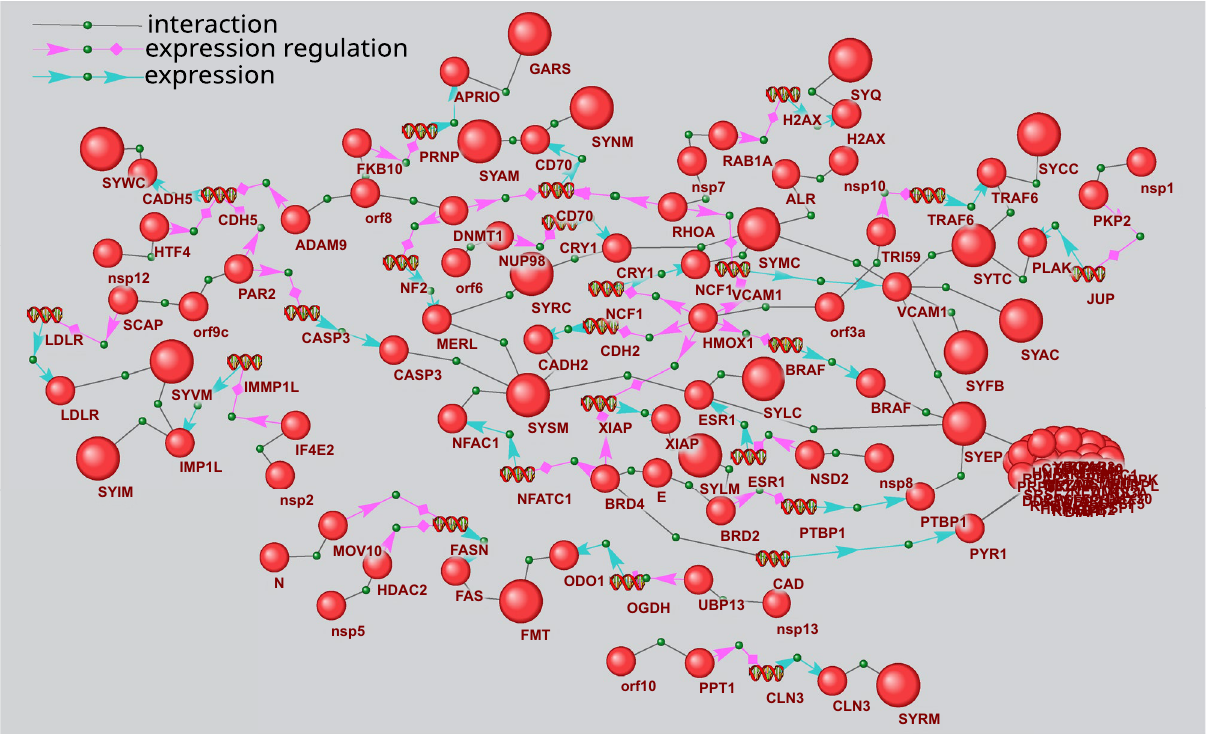
Figure 2. Gene networks describing P 7 pathways, by which the virus, potentially, affects the proteins of aminoacyl-tRNA biosynthesis. The bigger balls show the proteins of aminoacyl-tRNA biosynthesis, while the smaller ones designate other proteins. Spirals designate the